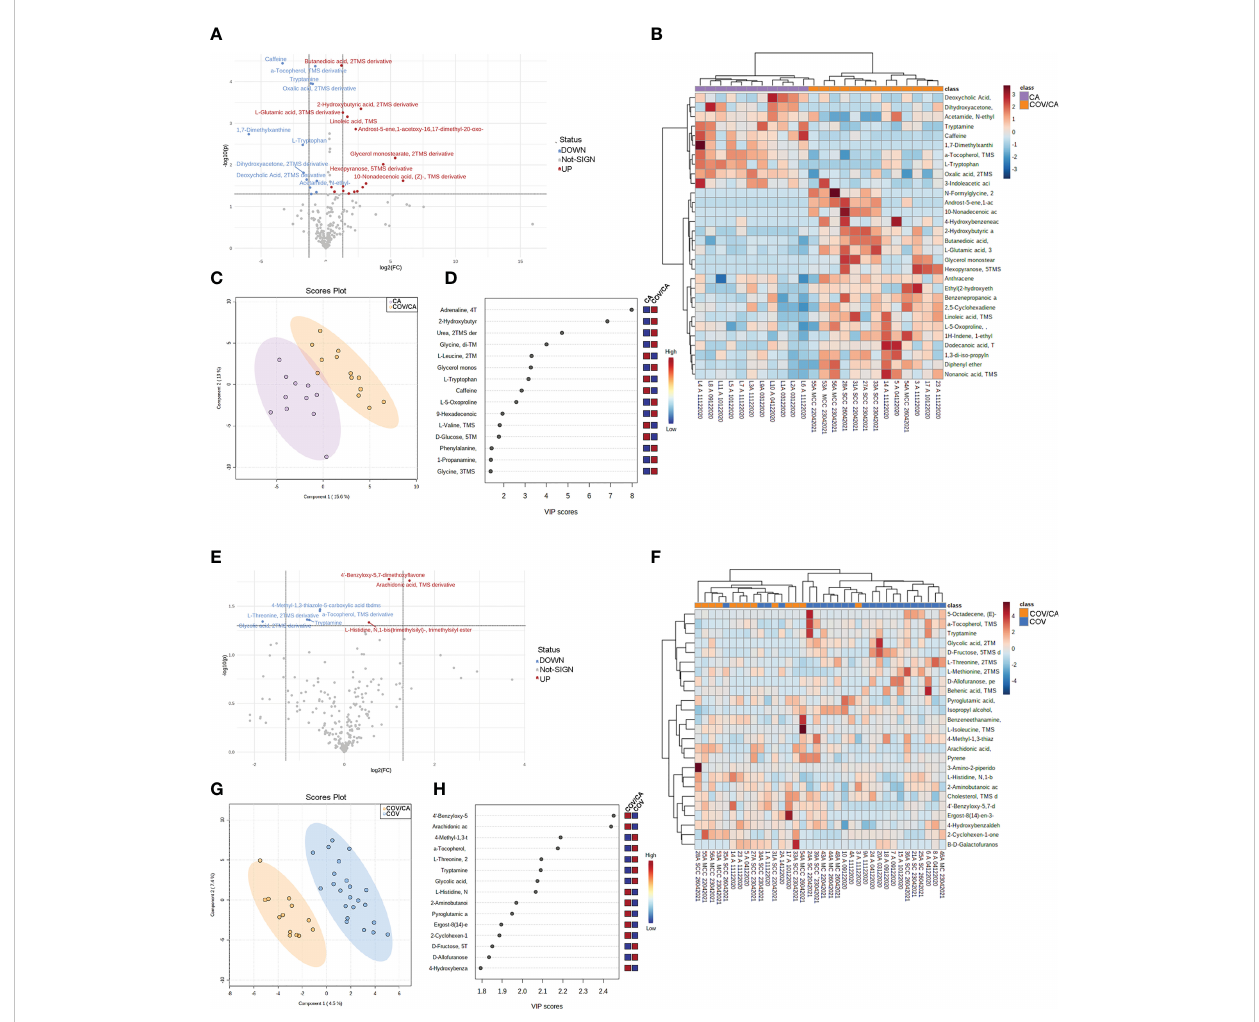
FIGURE 7 Plasma metabolome in cancer patients with or without COVID-19. (A) volcano plot depicting the modulation of 230 small molecules quanti fi ed (FC > 1.3, p ≤ 0.05), 25 small molecules were modulated, of which 16 up-regulated and 10 down-regulated. (B) Hierarchical heat maps of levels of quanti fi ed molecules, highlighting the two clusters of samples, with COV/CA in orange and CA in purple. (C, D) Partial least square discriminant analysis (PLS-DA) of metabolome pro fi les, showing (C) the presence of two separate groups of patients and (D) the most important discriminating variables for each group. (E – H) Volcano plot, heatmap of molecule levels and PLS-DA of COV/CA vs COV, 5 small molecules were down regulated while 3 increased their levels. CA ( n = 11), COV ( n = 23) and COV/CA ( n = 13)